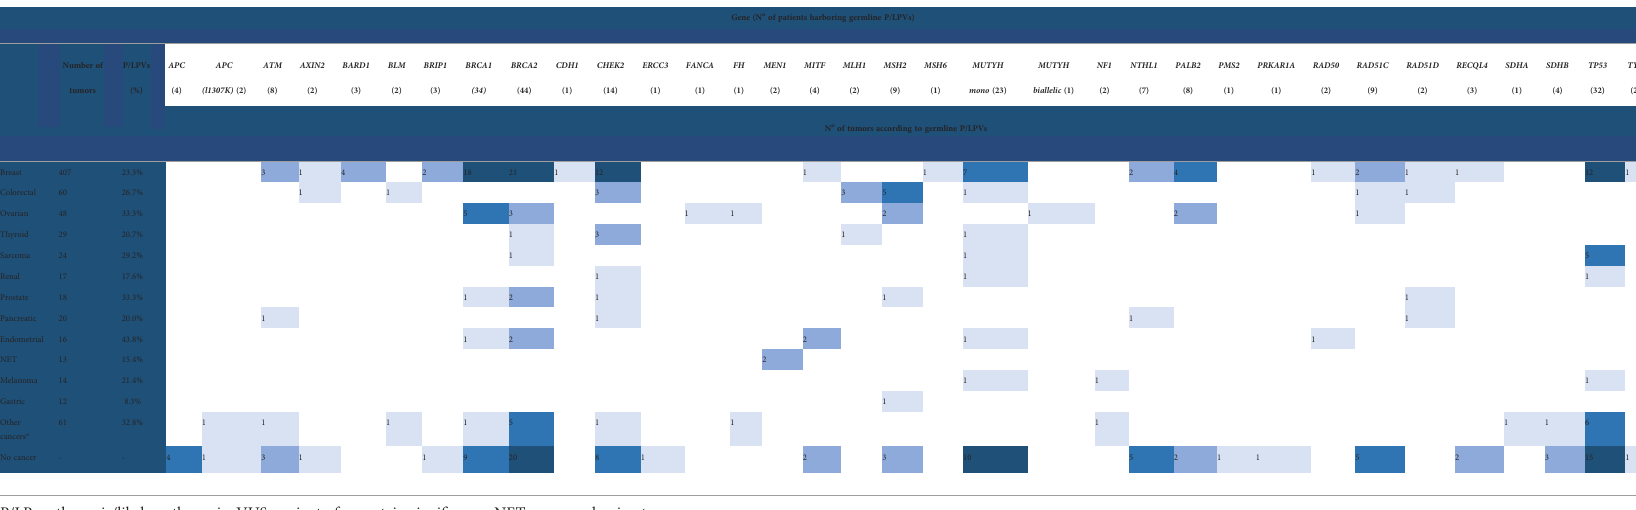
P/LP, pathogenic/likely pathogenic; VUS, variant of uncertain signi fi cance; NET, neuroendocrine tumor. *Other cancers included testicular, lymphoma, leukemia, schwannoma, urothelial, bladder, adrenocortical, head and neck, skin (non-melanoma), soft tissue, lung, central nervous system, uterus, parotid, hepatocarcinoma, pheochromocytoma, appendix, gallbladder, and multiple myeloma. Adapted from Samadder et al. (9). Color shading is related to the frequency of each alteration, darker shades represent higher